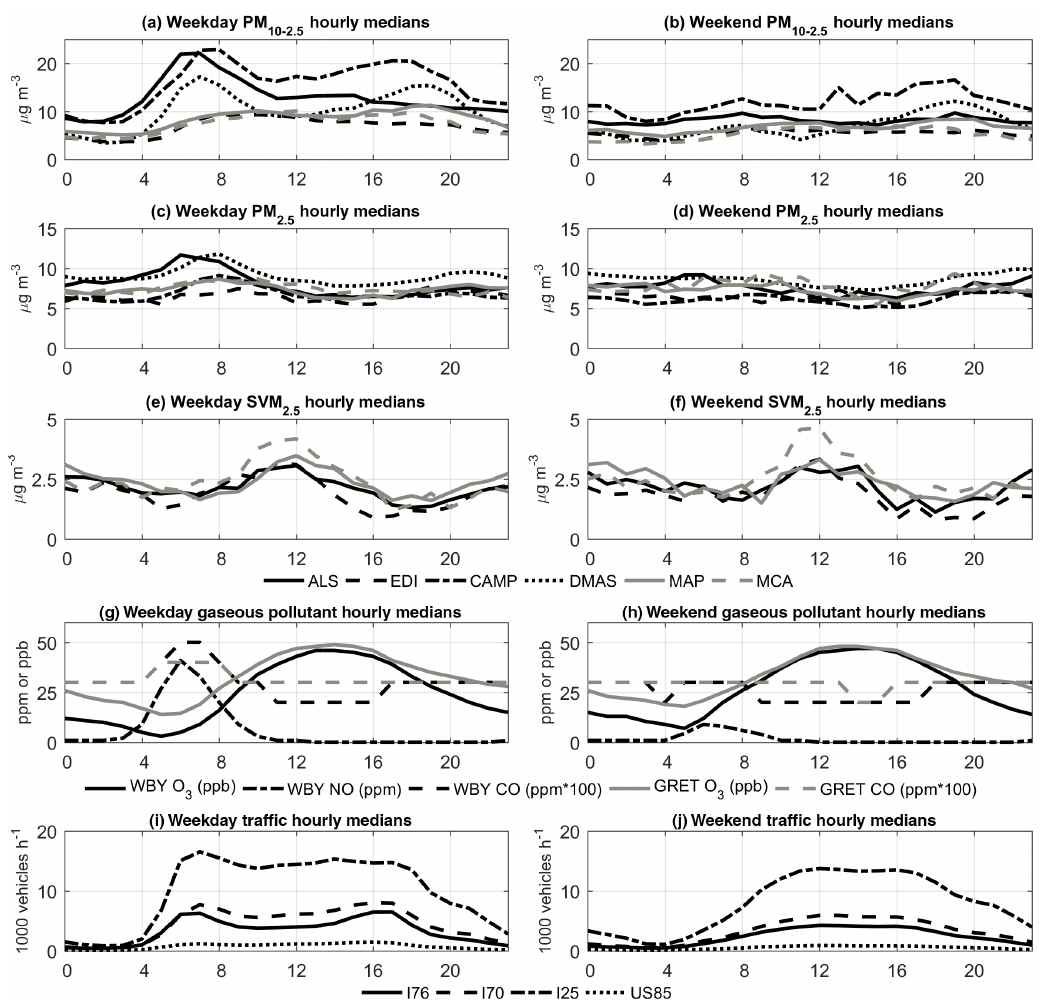
Figure 2. Diurnal trends (time-of-day medians) of (a) PM 10 − 2 . 5 on weekdays, (b) PM 10 − 2 . 5 on weekends, (c) PM 2 . 5 on weekdays, (d) PM 2 . 5 on weekends, (e) SVM 2 . 5 on weekdays, (f) SVM 2 . 5 on weekends, (g) weekday gas-phase pollutants, (h) weekend gas-phase pollutants, (i) weekday traffic volumes, and (j) weekend traffic